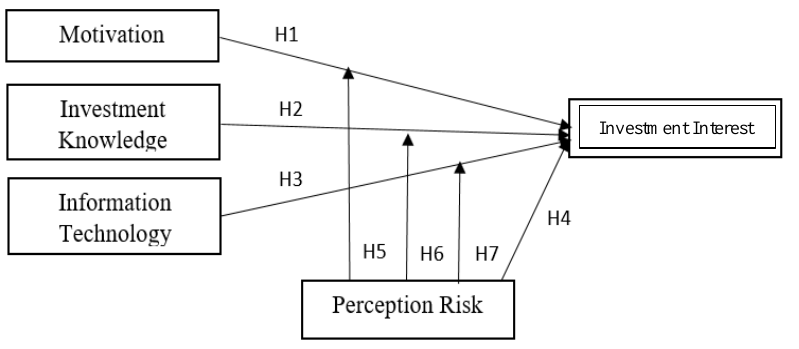
Figure 1: Conceptual Model of the Study; Source: Authors